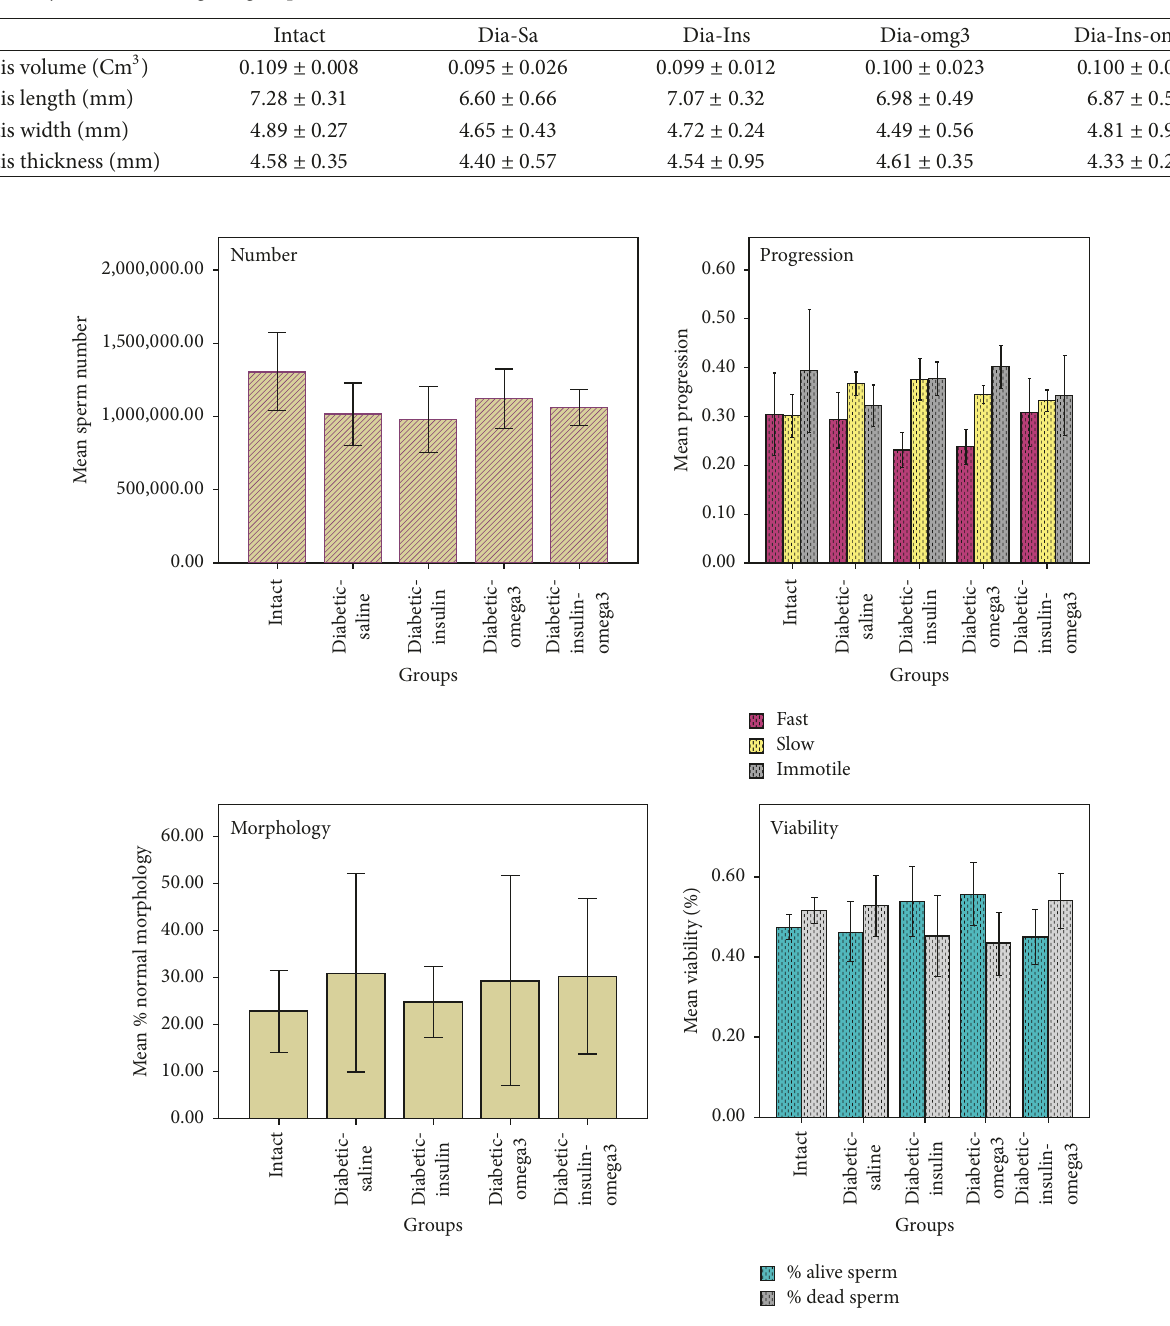
Table 2: Testis dimensions and volume were measured in the intact, diabetic-saline (Dia-Sa), diabetic-insulin (Dia-Ins), diabetic-omega3 (Dia-omg3), and diabetic-insulin-omega3 (Dia-Ins-omg3) groups by a standard caliper and digital balance. None of the parameters was statistically different among the groups.